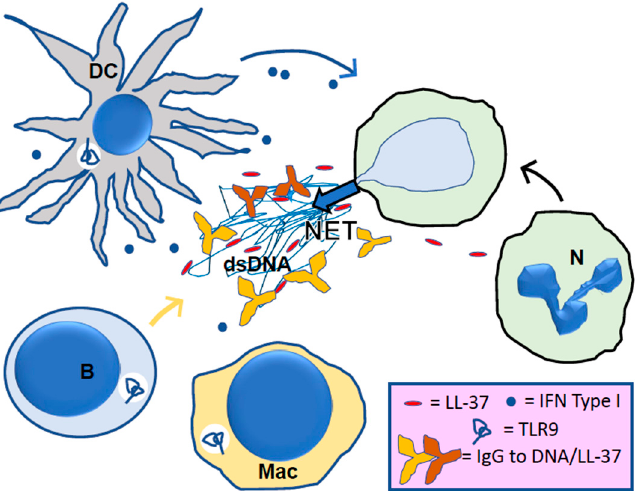
Figure 3. Roles of LL-37 in inflammation and autoimmunity. Neutrophils (N) arrive at site of inflammation and are stimulated to release NETs consisting of double-stranded (ds) DNA associated with histones and numerous other granule components, proteases and myeloperoxidase. The LL-37 peptide is released during NETosis and binds to NET chromatin or diffuses from the site. The LL-37 peptide may serve as chemoattractant for additional neutrophils, macrophage (Mac) or B lymphocytes (B). In autoimmunity, B cells may secrete IgG to dsDNA and to LL-37. Together with NET components, the IgG will be internalized via Fc receptors and stimulate endosomal toll-like receptor 9 (TLR9). In response to TLR9 stimulation, dendritic cells (DC) may secrete type I interferons that further stimulate the immune